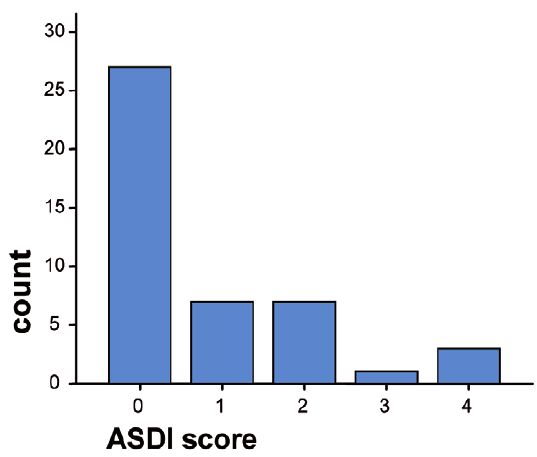
Figure 3. Score distribution on the